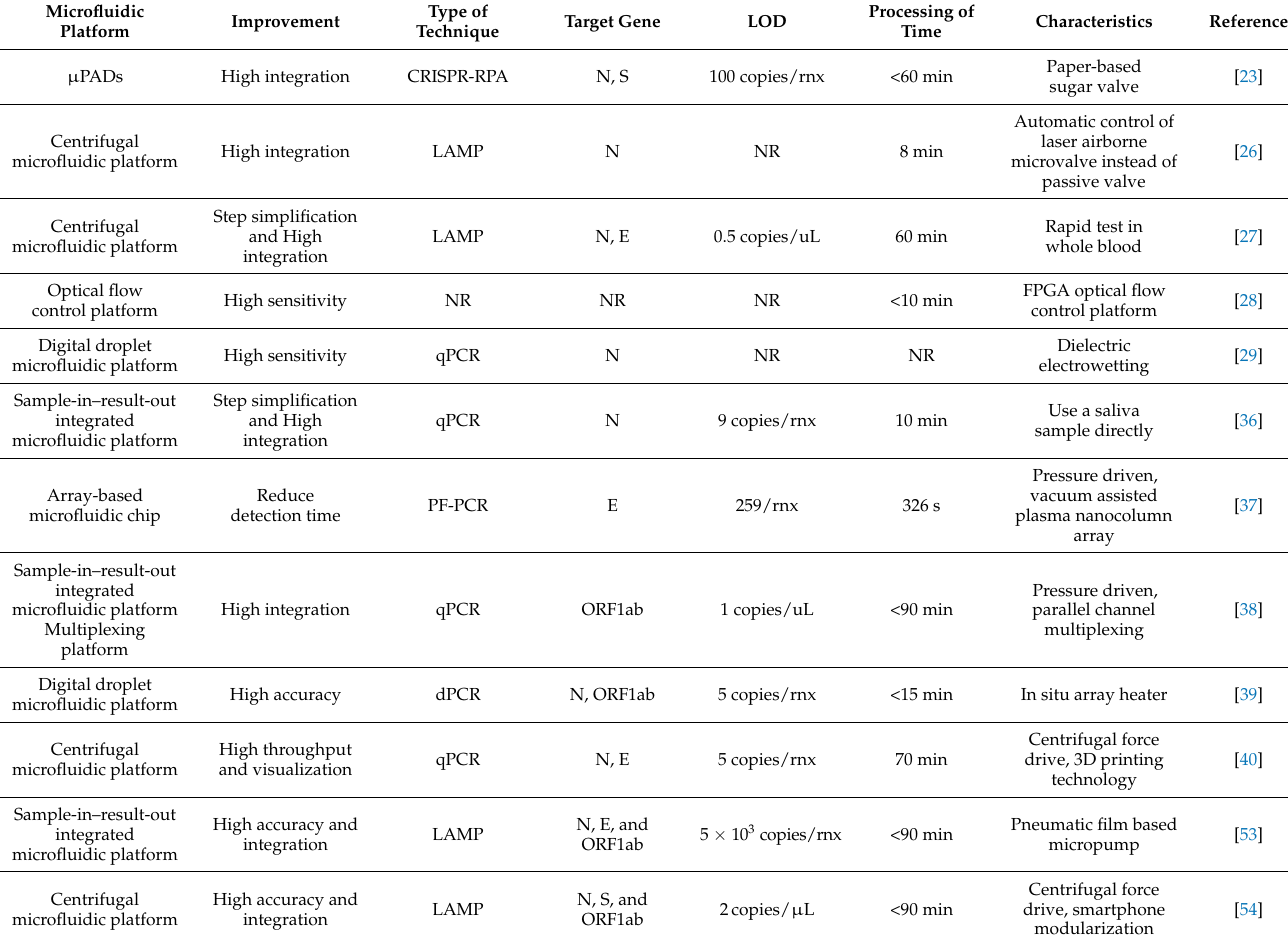
Table 1. Microfluidic assays for the detection of SARS-CoV-2 nucleic